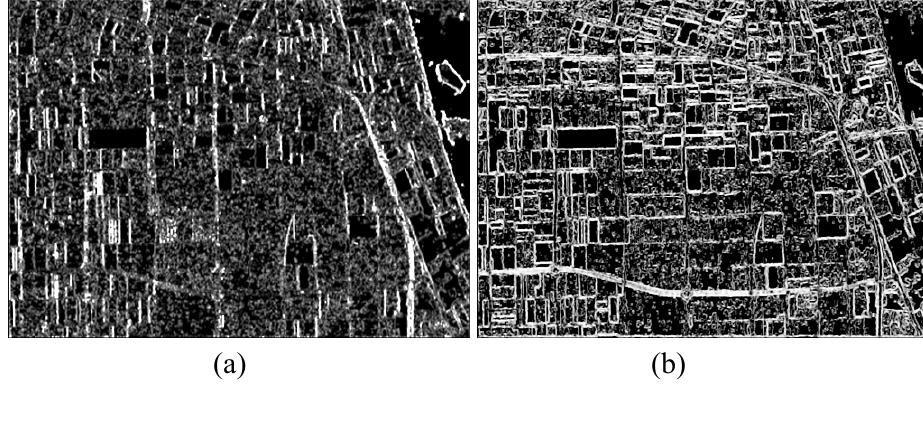
Figure 12. GLCM-based features of T